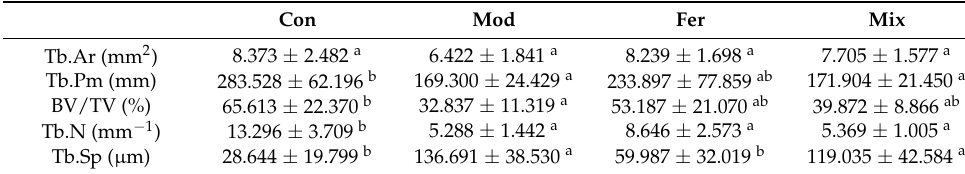
Image Pro Plus 6.0 software was used to obtain T.Ar, Tb.Ar, and Tb.Pm. BV/TV ratio, Tb.N, and Tb.Sp were calculated. Values are expressed as mean ± SD (n = 6). With p < 0.05, values with various superscript letters differ